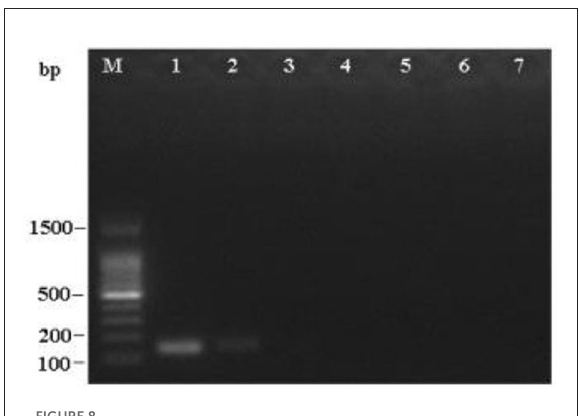
FIGURE8 Sensitivity of the PCR assay for R. subnigricans . A dilution series of R. subnigricans DNA was prepared as follows: (1) 5 ng; (2) 500 pg; (3) 50 pg; (4) 5 pg; (5) 500 fg; (6) 50 fg; and (7) no template for negative